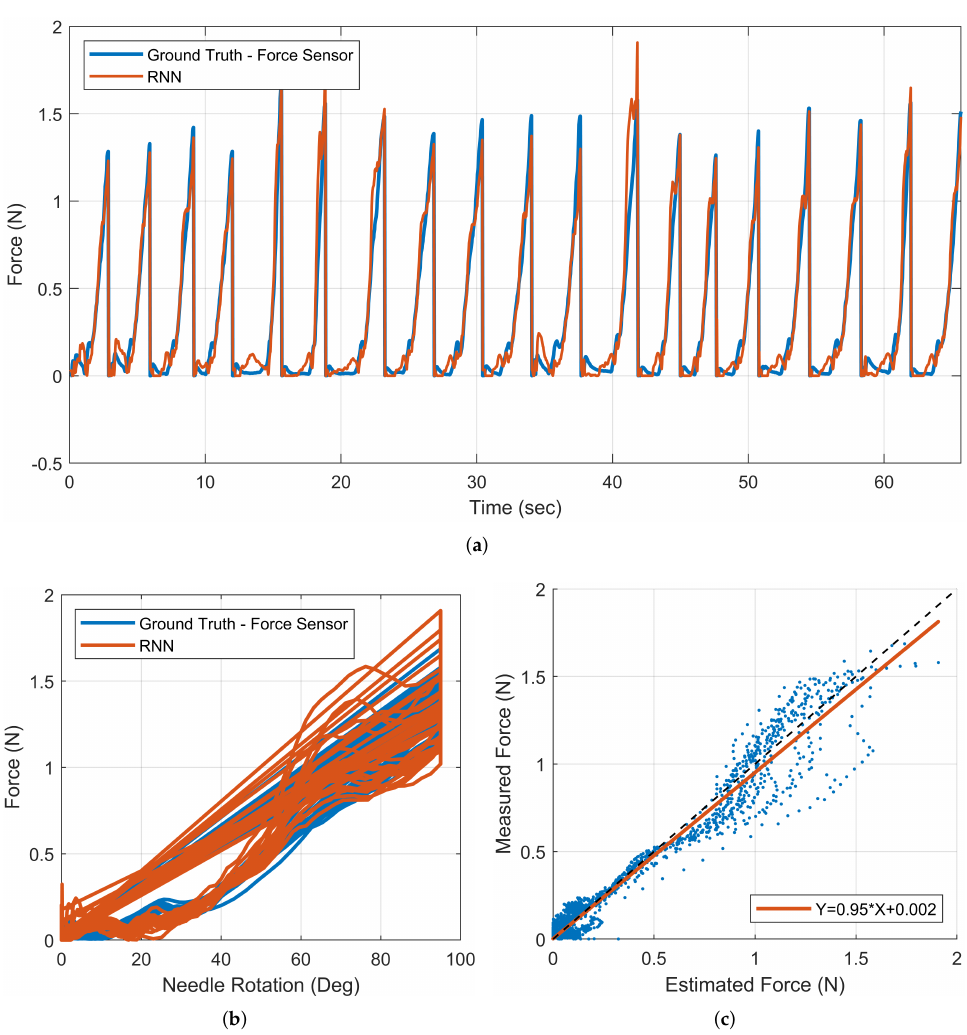
Figure 10. Results for a sample output of the RNN model. ( a ) the force–time profile of the recorded force versus the estimated force calculated by the force model; ( b ) the force–needle rotation profile; ( c ) fitted line to the pairs of the target values versus the estimated force values with an ideal slope of 1 shown with a black dashed